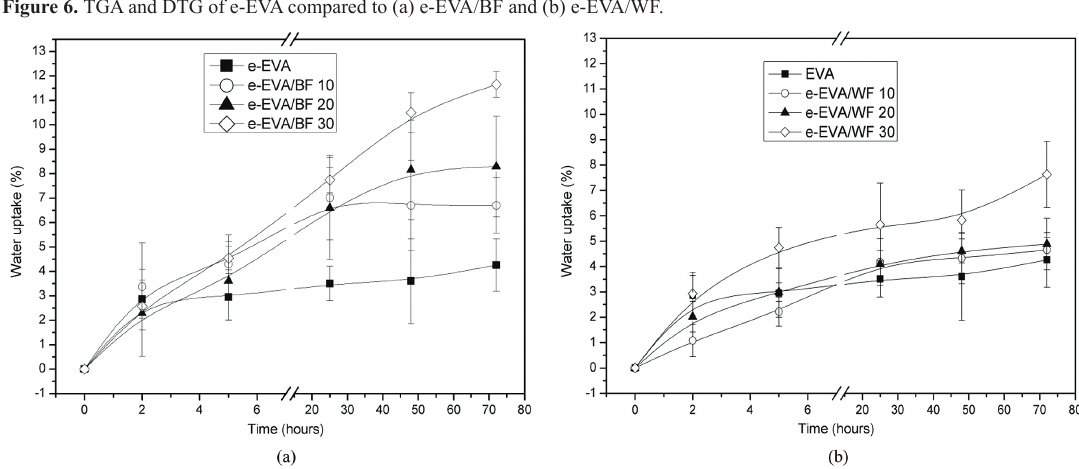
Figure 7. Water absorption of e-EVA and of expanded composites (a) produced with BF and (b) produced